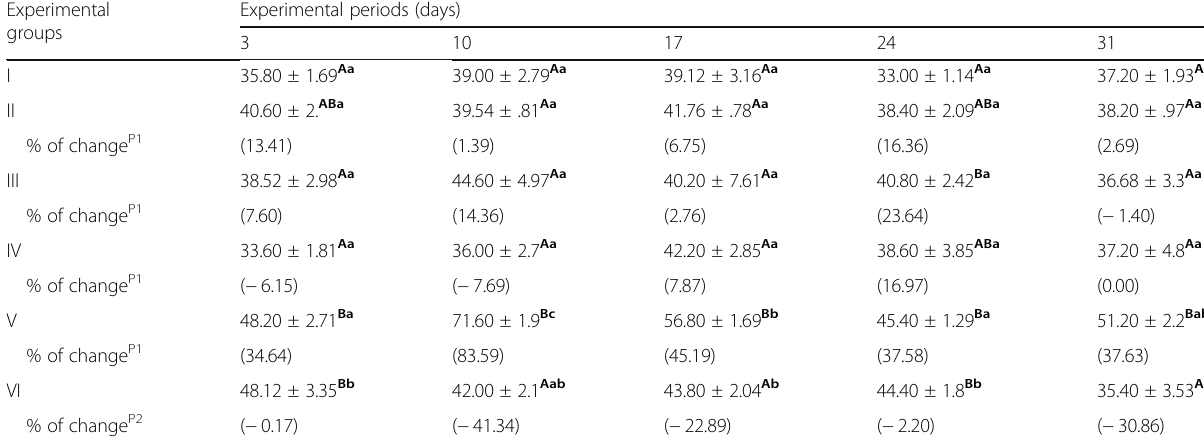
Table 7 Plasma levels of IL-1 β (pg/ml) in the experimental groups at the experimental periods Experimental Experimental periods (days) groups